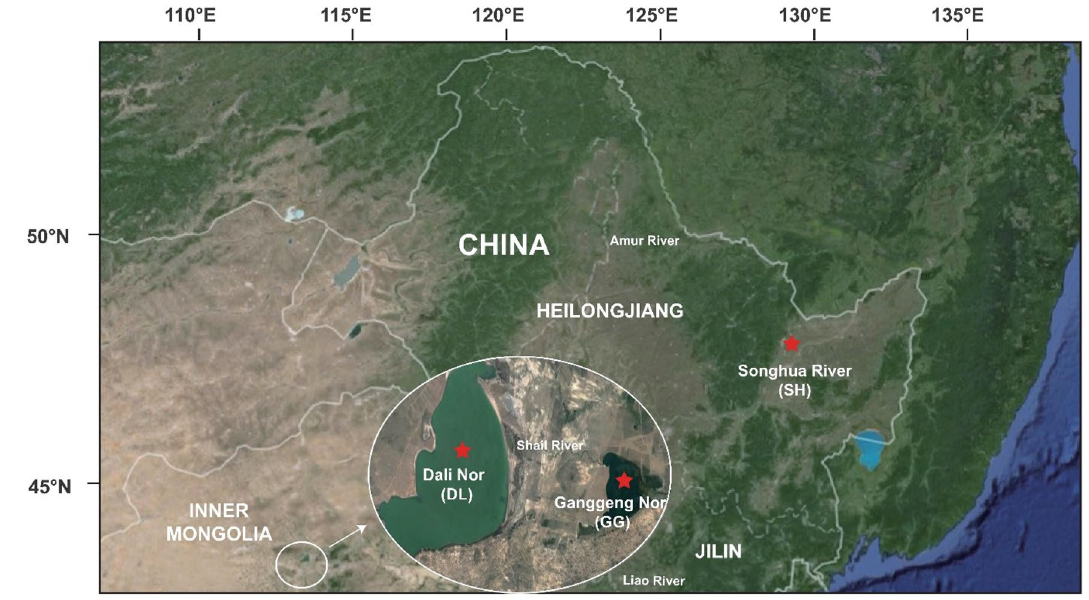
Figure 1. Geographical distribution of the sampled populations (solid red five-pointed stars represent the sampling locations). The map in the background has been generated by R package ‘ggmap’ (https ://cran.r-proje ct.org/web/packa ges/ggmap /) 10